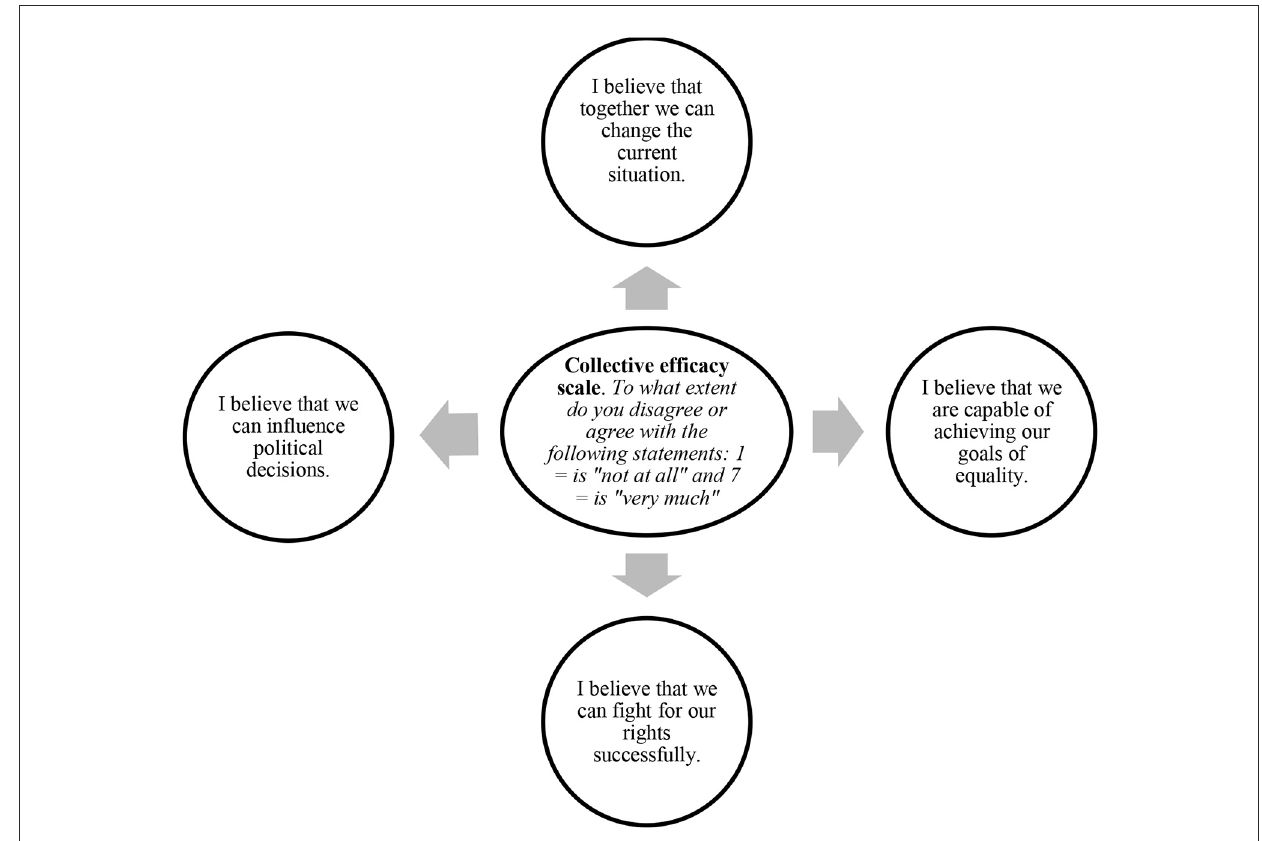
FIGURE3 Measures of collective efficacy. Source: van Zomeren et al. (2010) and Zumeta et al. (2020).